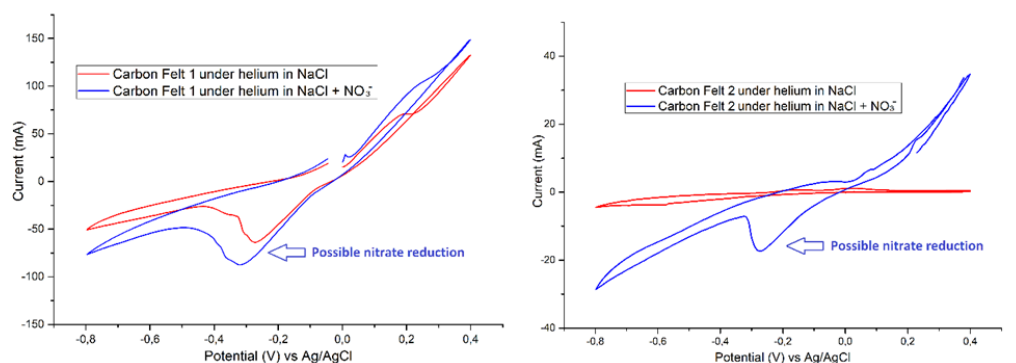
Figure 7. Different cyclic voltammograms of carbon felt (i.e., graphite felt) before and after Sodium Nitrate addition in the electrolyte under helium saturation. Possible nitrate reduction is showed by blue arrows.